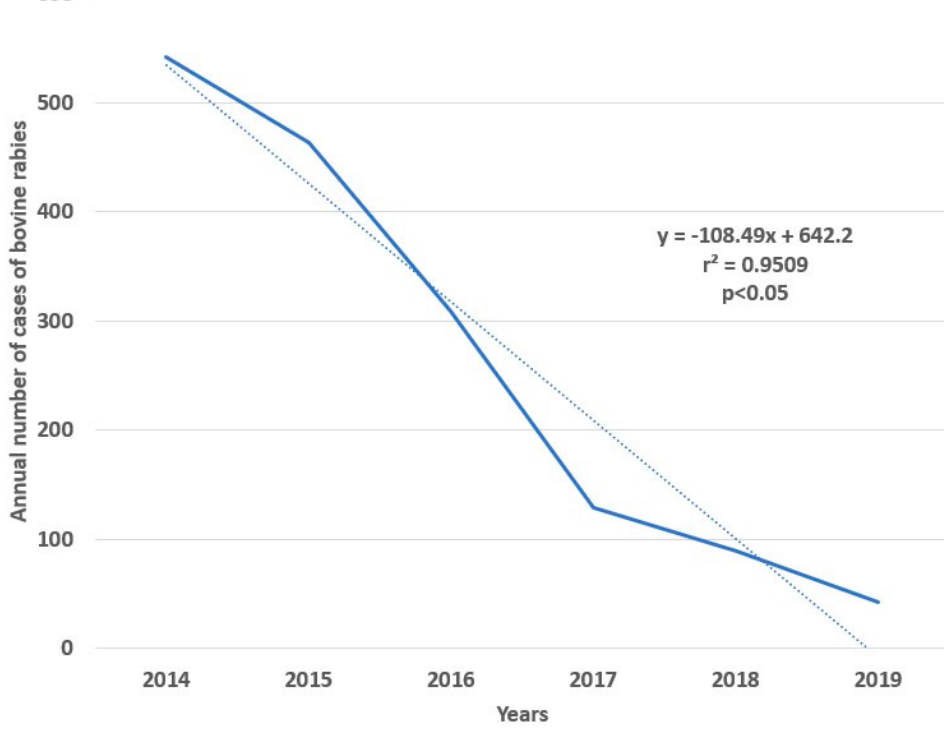
Figure 2. Case trend from 2014 to 2019, bovine rabies, Colombia.